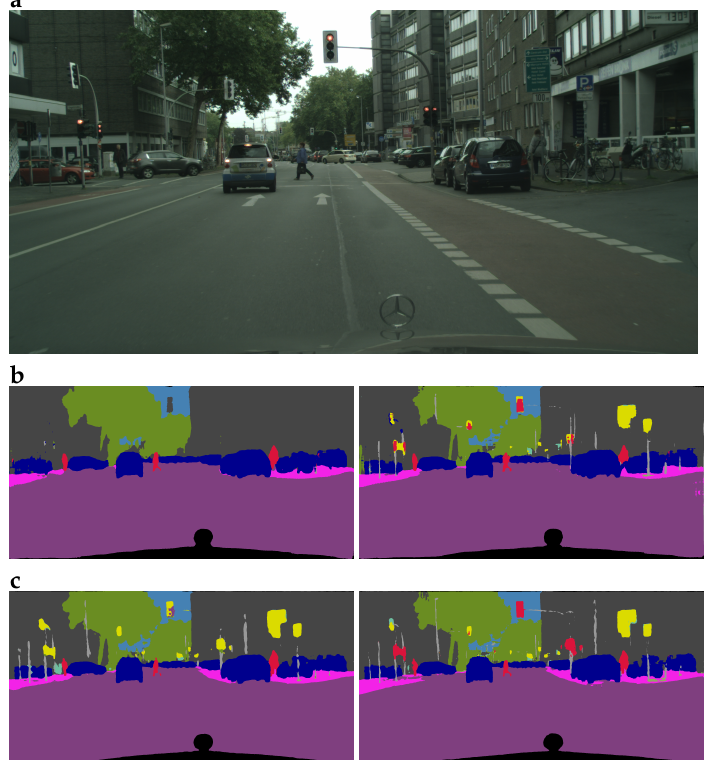
Figure 2. Semantic segmentation of a sample image with different models: ( a ) the original image; ( b ) segmentation masks produced with MobileNetV2 models: trained on Cityscapes images only ( left ) and on CCM-50 split ( right ); ( c ) segmentation masks produced with Xception models: trained on Cityscapes images only ( left ) and on CCM-25 split ( right ). Note the differences in the ability of the models to classify traffic lights and road